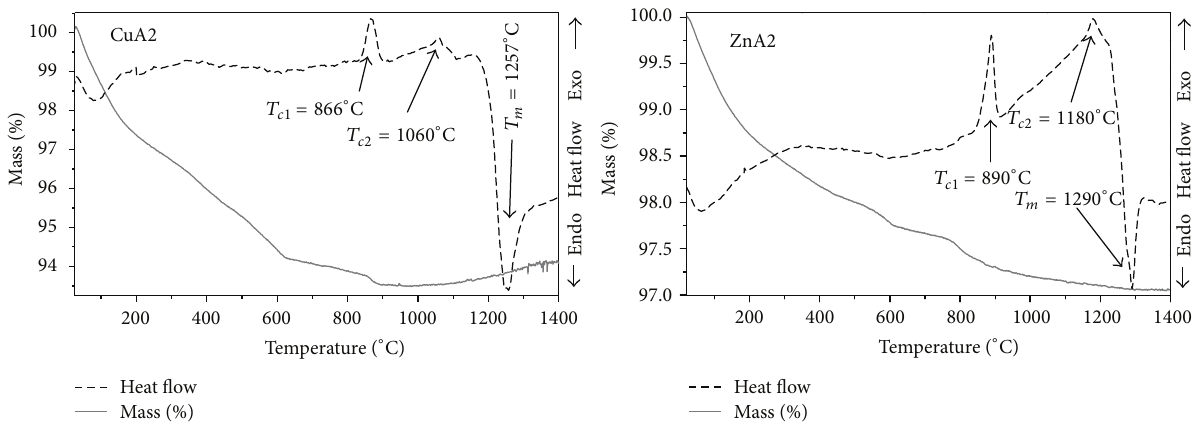
Figure 1: TG and DSC curves of CuA2 and ZnA2 glass